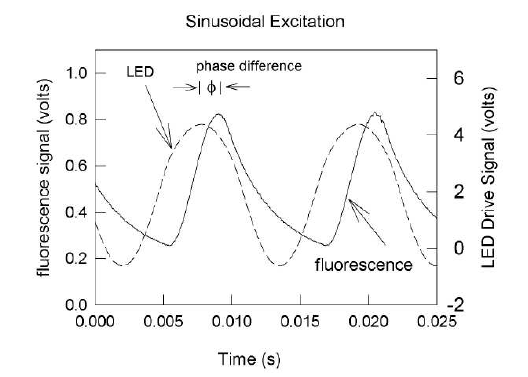
Figure 40. Sinusoidal wave used to excite phosphor. Taken from Allison et al .